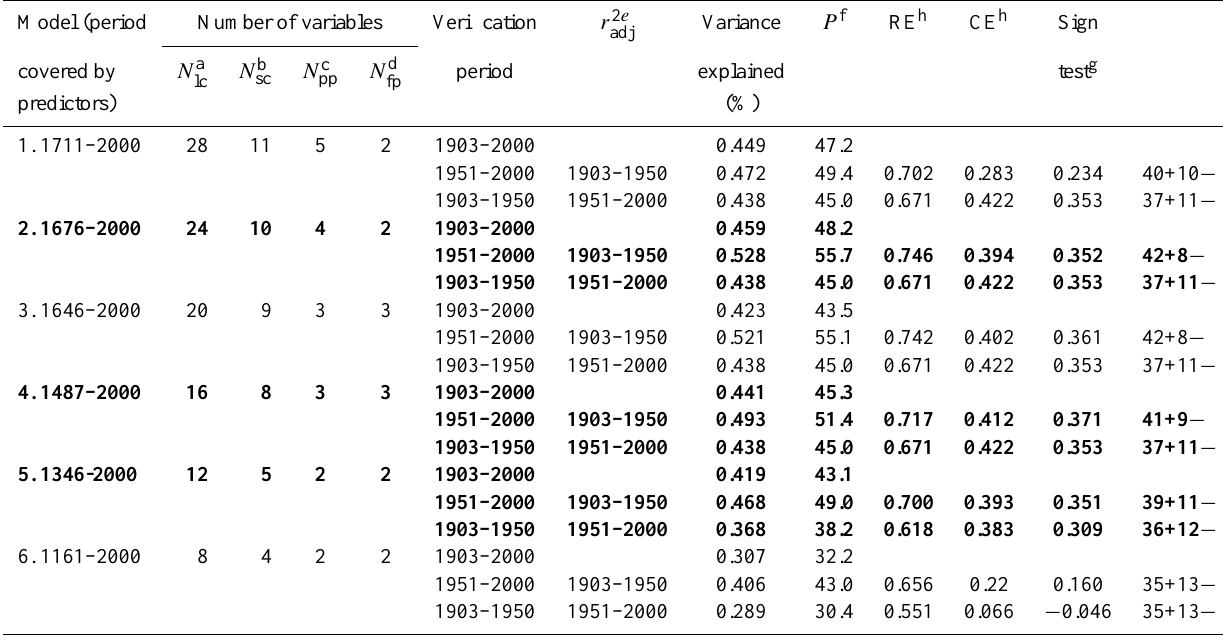
Table 2. Calibration and verification statistics for six nested reconstruction models. The models used in the final nested reconstruction are shown in bold. Model (period Number of variables Verification r 2 e Variance P f RE h CE h Sign adj N b sc N c pp N d covered by N a period explained test g lc fp predictors)